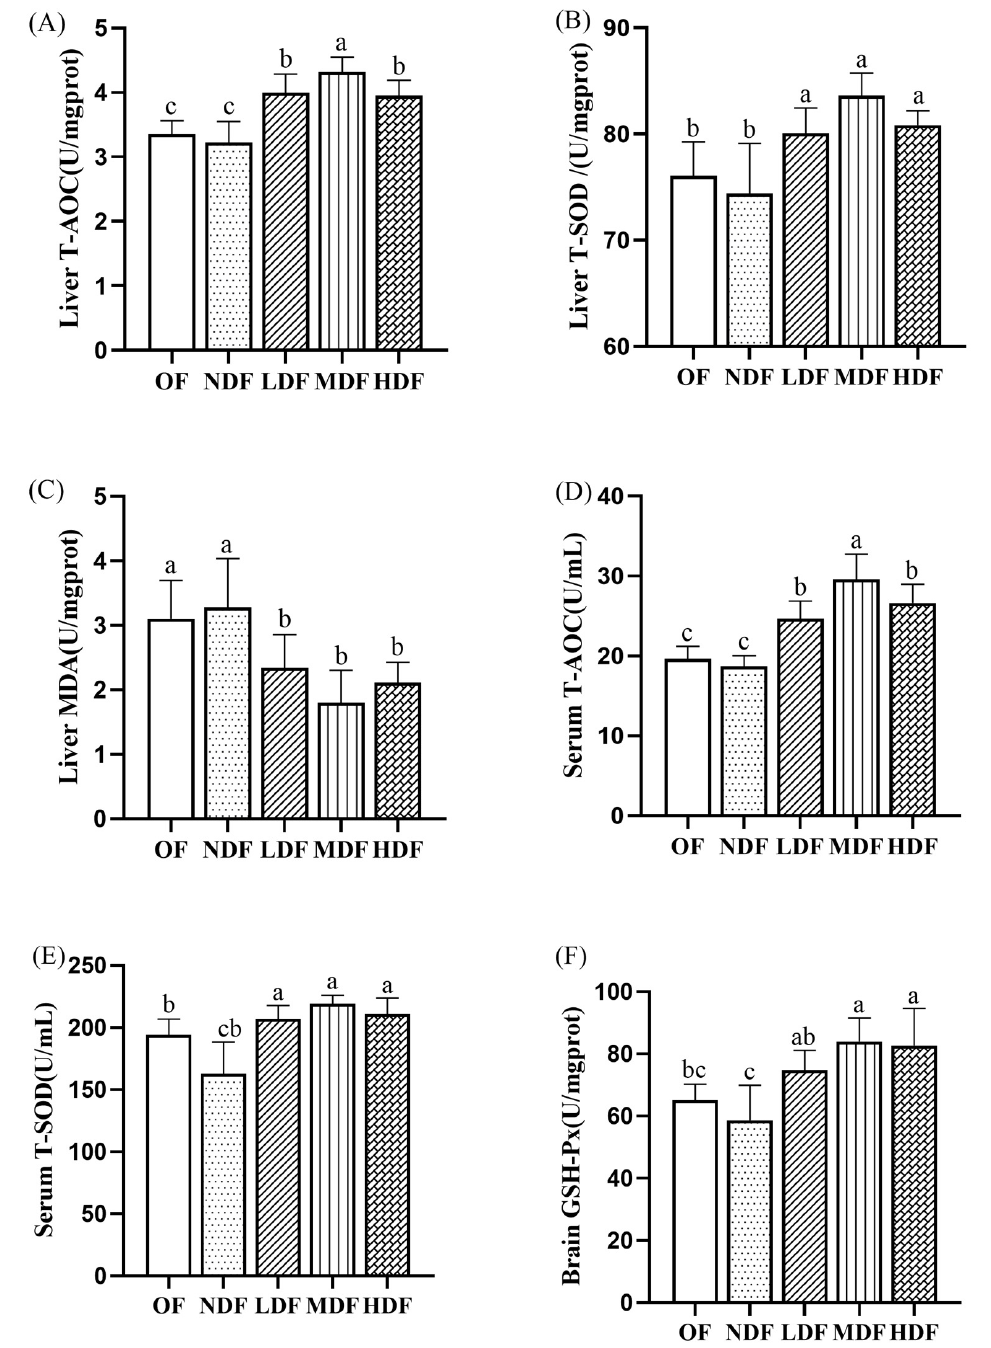
Figure 3. Effect of CDFC on T-AOC and T-SOD activity in mouse liver tissues ( A , B ) and serum ( D , E ); MDA content in liver ( C ) and GSH-Px level in brain tissue ( F ). Different superscript letters denote a significant difference in the same index ( p < 0.05).